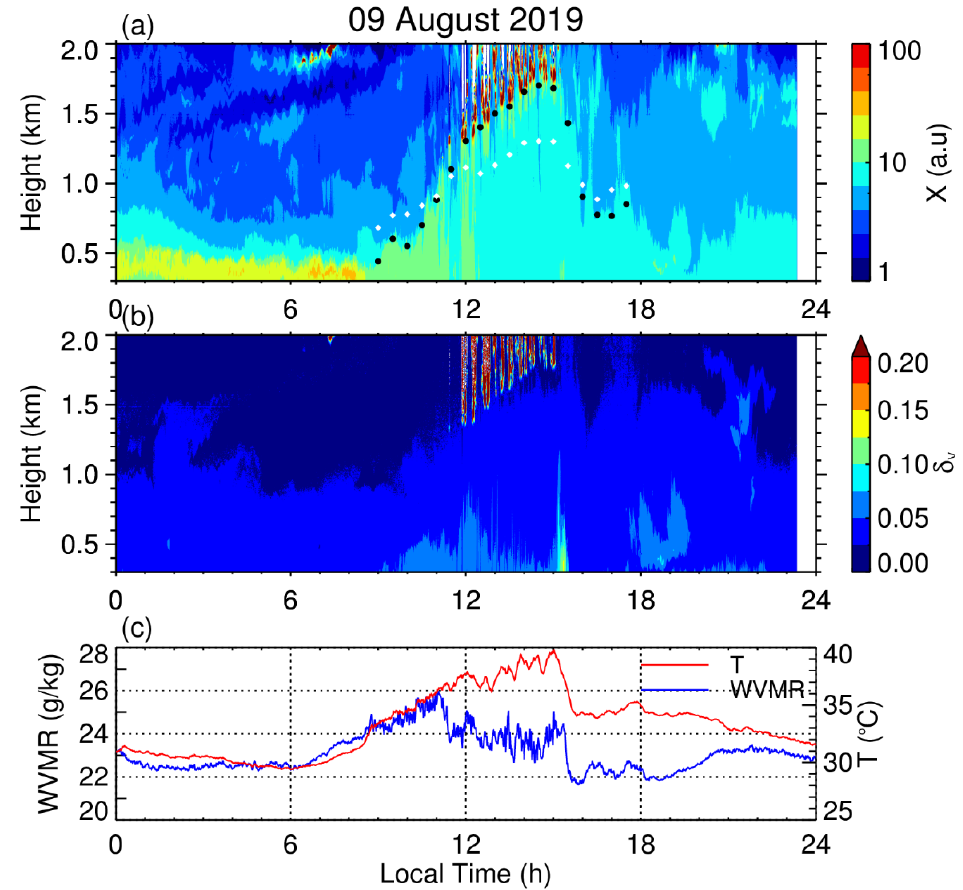
Figure 2. Time–height contour plots (1 min/3.75 m resolution) of ( a ) range-squared-corrected signal X; ( b ) volume depolarization ratio δ V measured by Wuhan University 532 nm polarization lidar